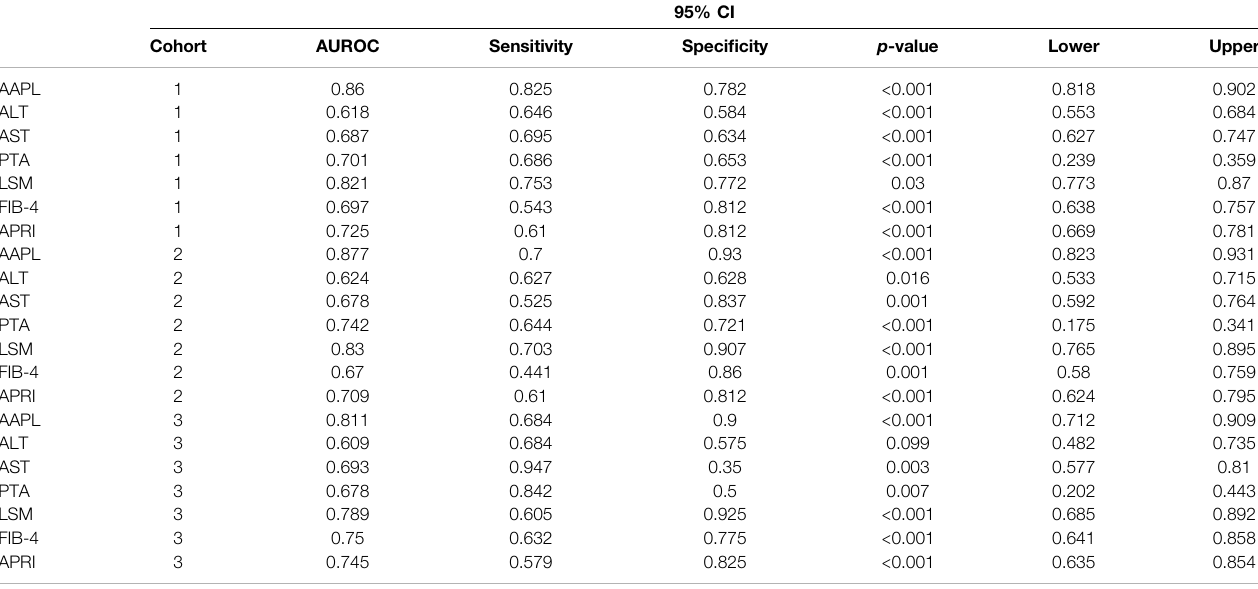
TABLE 3 | The area under the receiver operating characteristic curve (AUROC) of the nomogram, independent risk factors (identi fi ed in the multivariate logistic regression analysis), and other scoring systems (FIB-4 and APRI) in the development cohort (cohort 1), internal validation cohort (cohort 2), and independent validation cohort (cohort